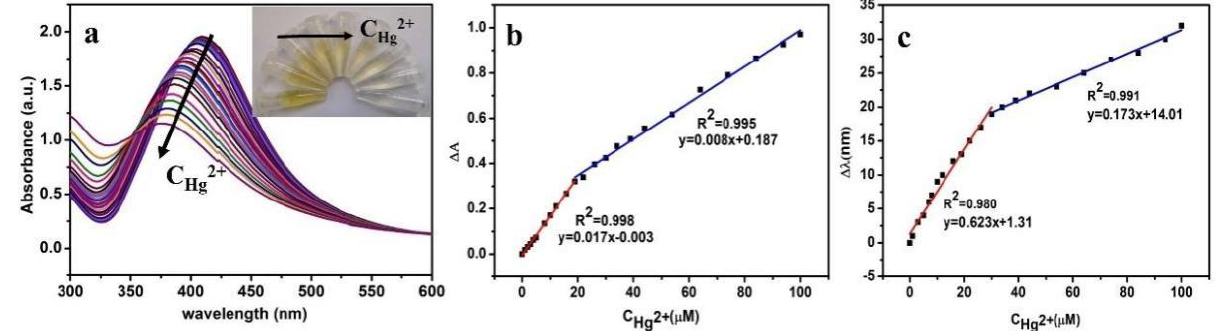
Figure 4. ( a ) UV–vis spectroscopy of the CMS/PVP-Ag NPs colloidal solution with different concen- trations of Hg 2+ (0–100 µ M), ( b ) The linear relative absorption intensity ∆ A; and ( c ) SPR band shift in ∆ λ over the concentration of Hg 2+ within the range of 0~100 µ M (R 2 represents the linear regression relationship between ∆ A and different concentrations of Hg 2+ ).